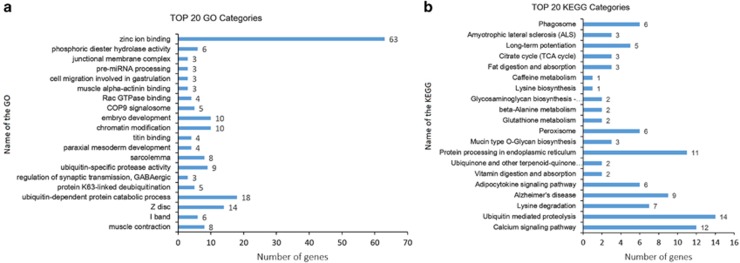
Gene Ontology and Kyoto Encyclopedia of Genes and Genomes pathways. Shown are the top 20 GO (a) and KEGG (b) terms of host genes from which differentially expressed circRNAs were uncovered